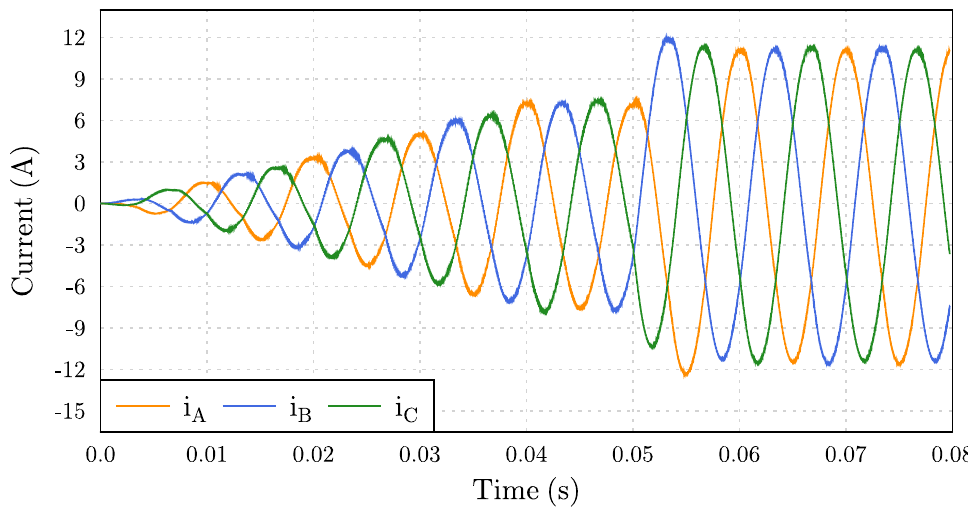
Figure 24. Output currents of the IMC controlled by